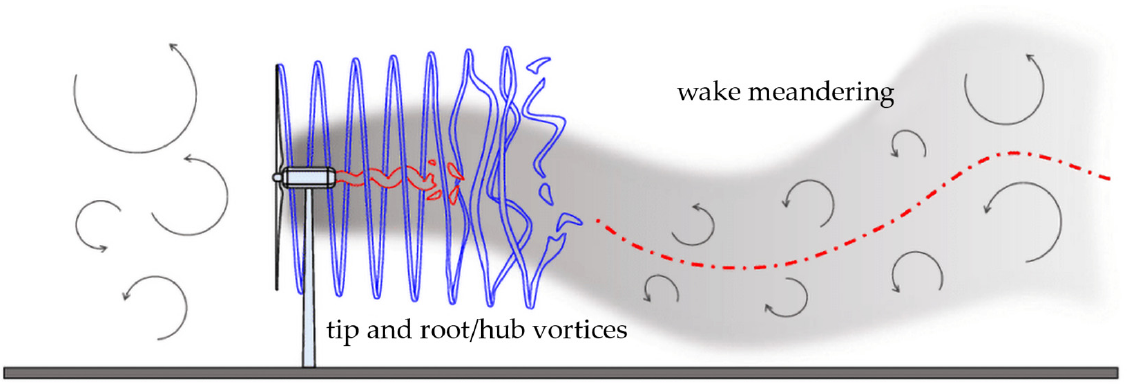
Figure 1. Schematic of wake meandering [12].